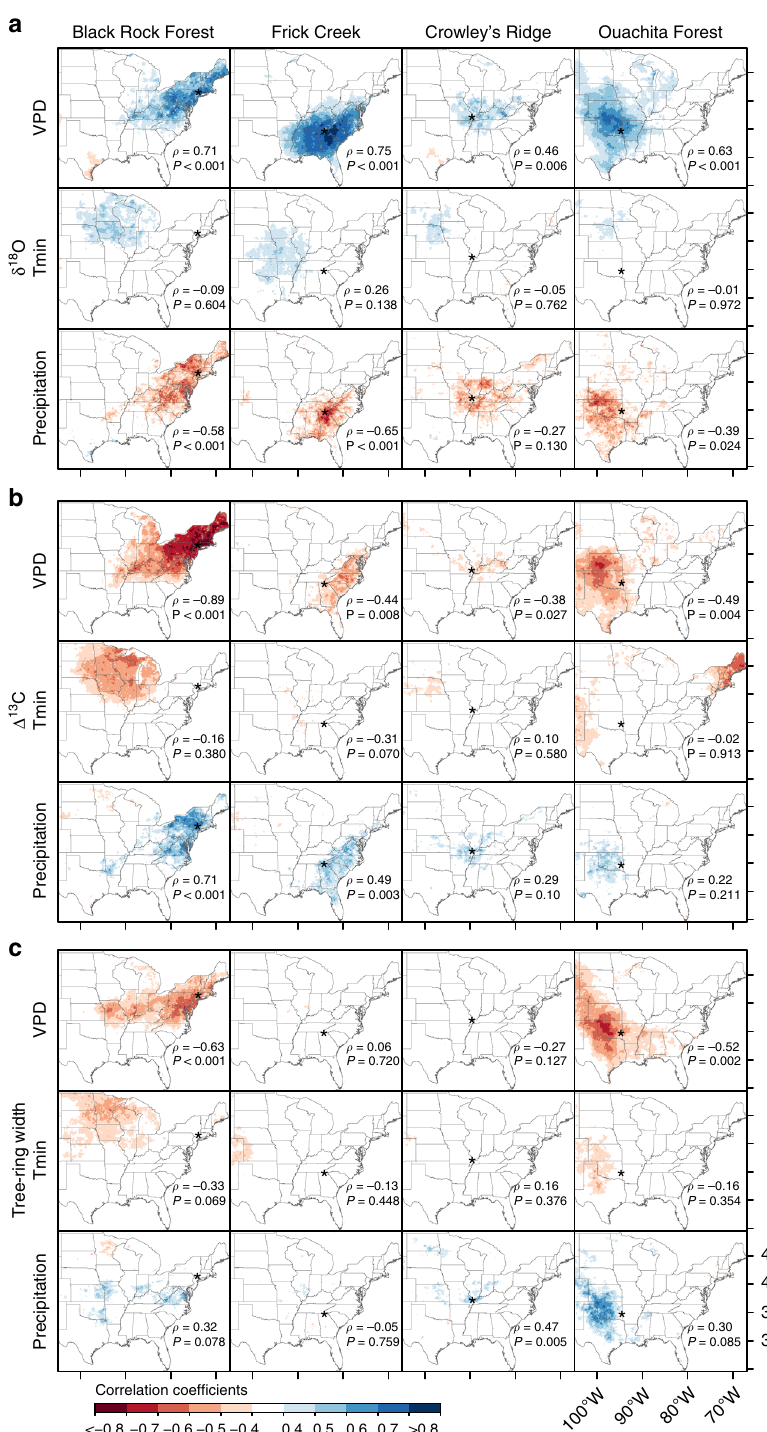
Fig. 4 Spatial fi eld correlations between tree-ring variables and gridded climate data. Correlation coef fi cients for the period 1982 – 2015 were calculated between annually resolved tree-ring δ 18 O ( a ), Δ 13 C ( b ), and width ( c ) chronologies measured at four sites and daytime mean May – August vapor pressure de fi cit (VPD), minimum temperature (Tmin), and precipitation. Study sites are represented by stars. Site-level correlations and their signi fi cance are indicated by Spearman ’ s rank correlation coef fi cient ( ρ ) and P -value ( P